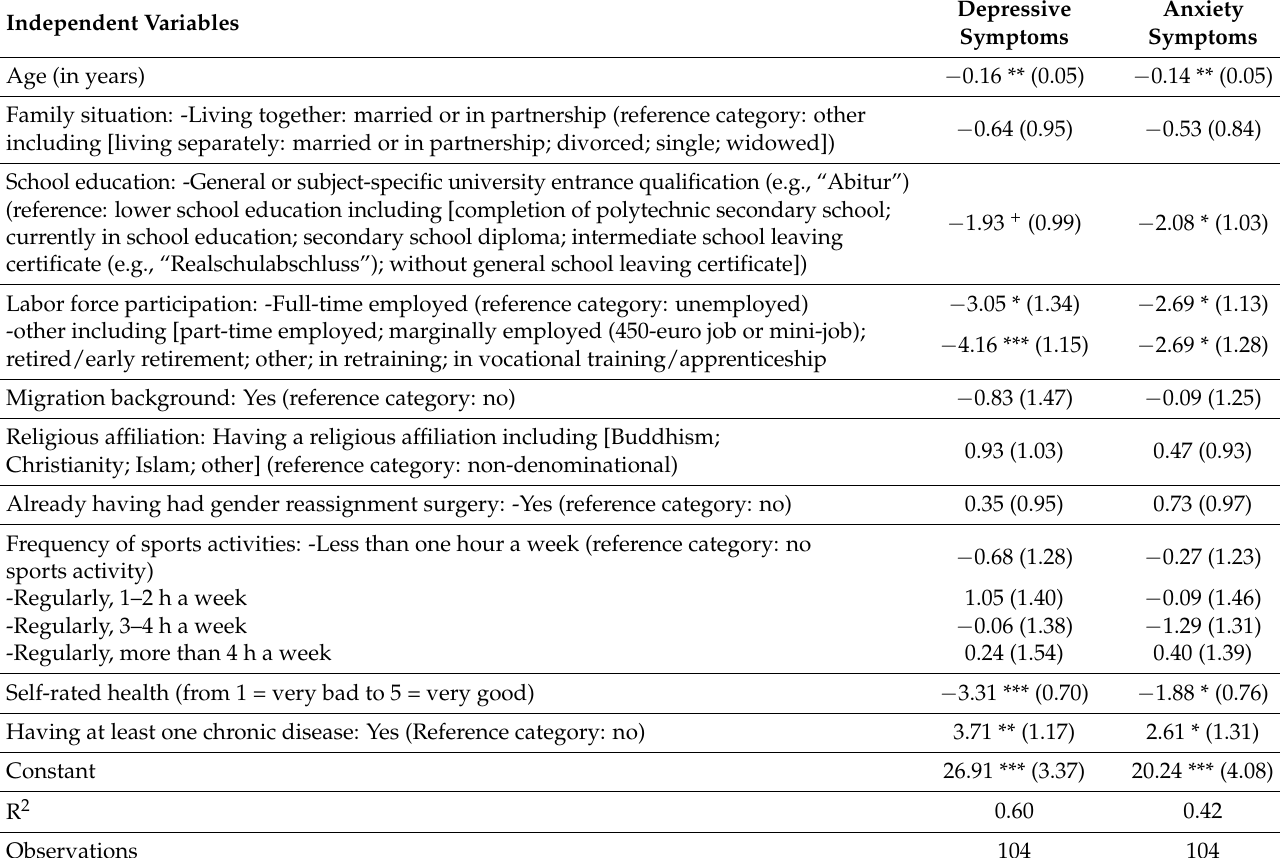
Table 2. Determinants of depressive symptoms and anxiety symptoms. Findings of the multiple linear